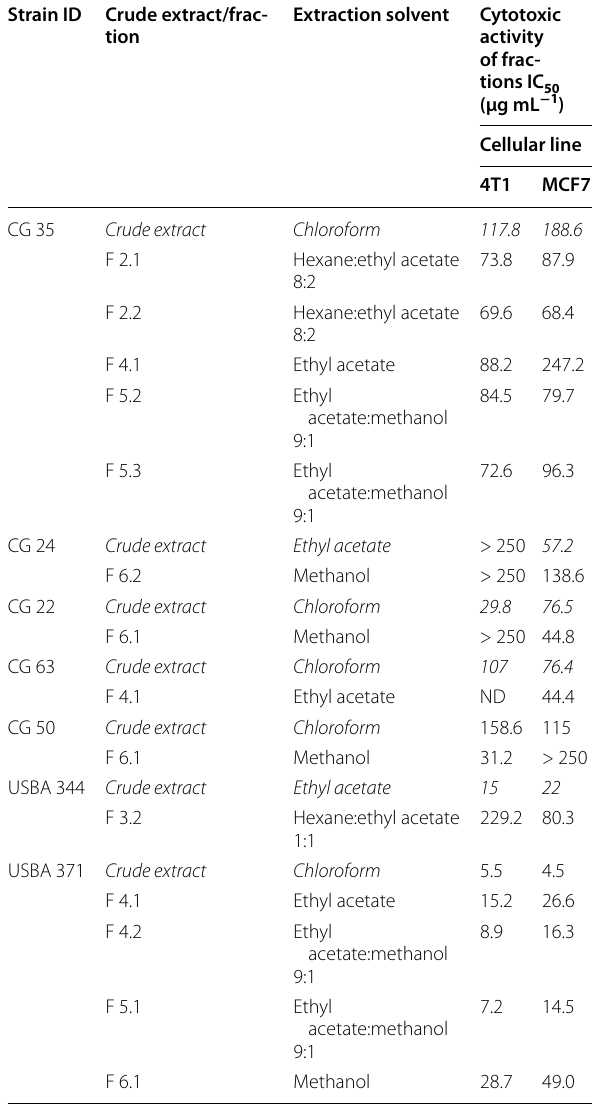
Table 2 Cytotoxic activities of fractions from the crude extracts Strain ID Crude extract/frac-